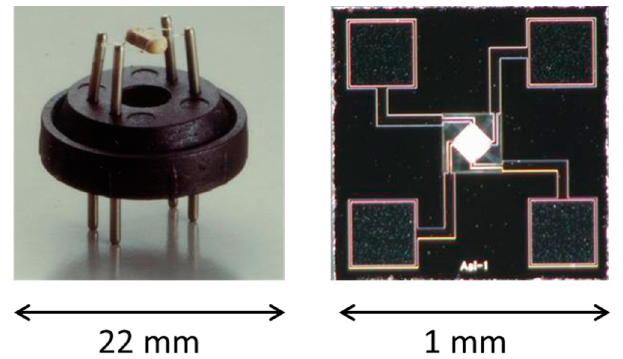
Figure 1. First and last generation of methane Figaro gas sensors (courtesy of Figaro